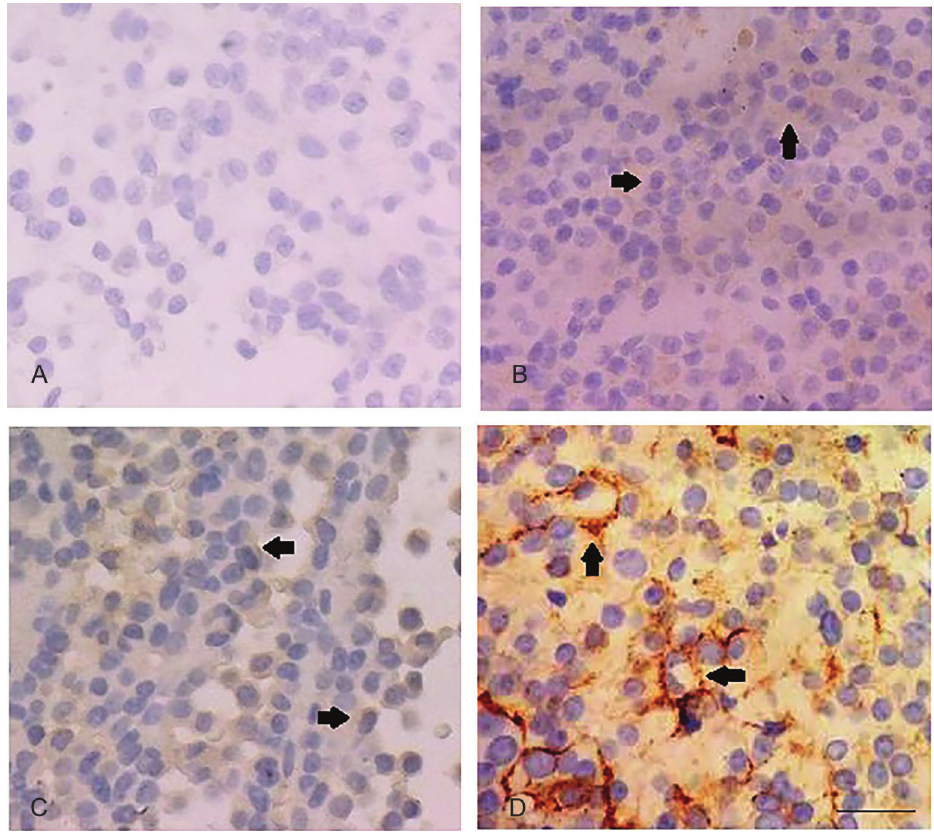
Figure 2. Immunohistochemical expression of NCAM (400 (cid:3) ). A , Negative expression ( (cid:1) ). B , Weak expression ( + ) ( fi nal score: 3). C , Moderate expression ( ++ ) ( fi nal score: 6). D , Strong expression ( +++ ) ( fi nal score: 8). All represent invasive tumors. Arrows indicate immunopositivity in plasma membrane. Bar=200 m m for all